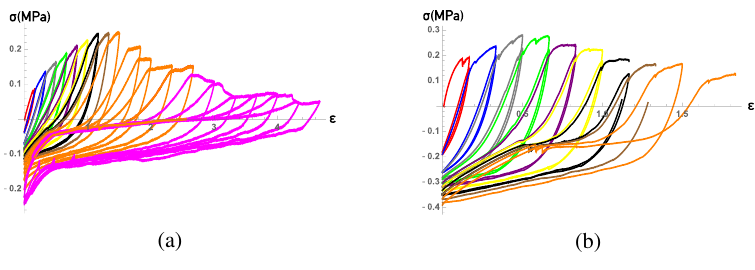
Figure 2: Strain-stress diagram: (a) – fragment of the dome, (b) – fragment of the neck.